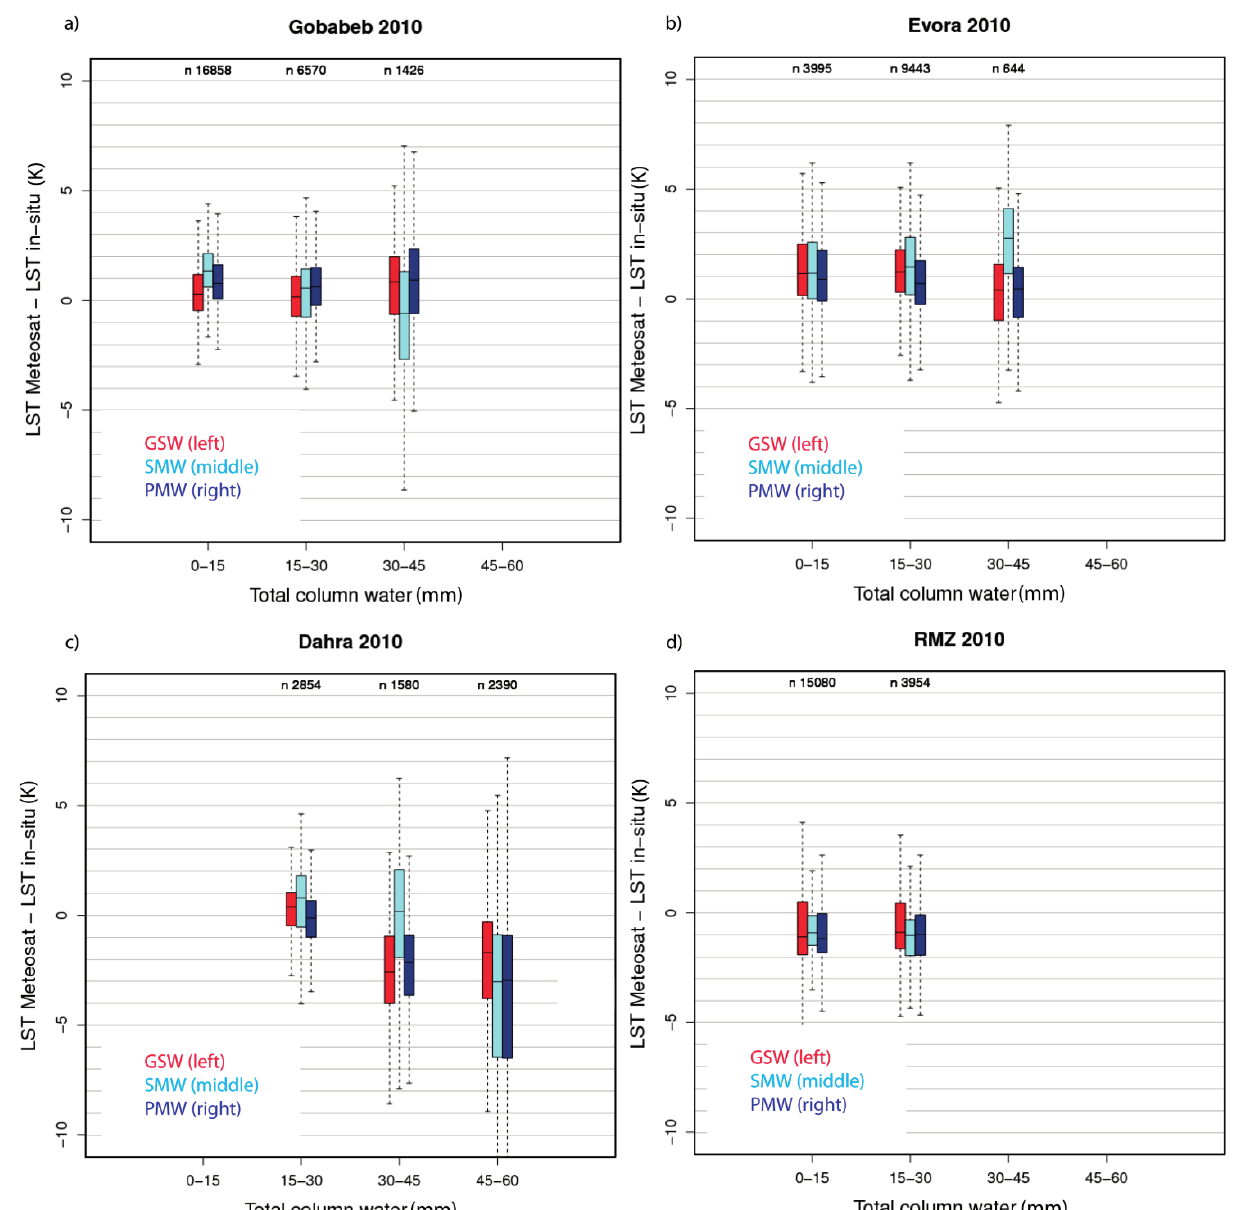
Figure 3. Comparison of LST between in situ measurements from the KIT sites and Meteosat-based retrievals for different TCWV classes. The boxplots show the median, the first and third quartile with whiskers at the 95th and fifth percentiles. GSW: the Satellite Application Facility on Land Surface Analysis’s (LSA SAF) operational GSW. ( a ) KIT Gobabeb station; ( b ) KIT Evora station; ( c ) KIT Dahra station; ( d ) KIT RMZ